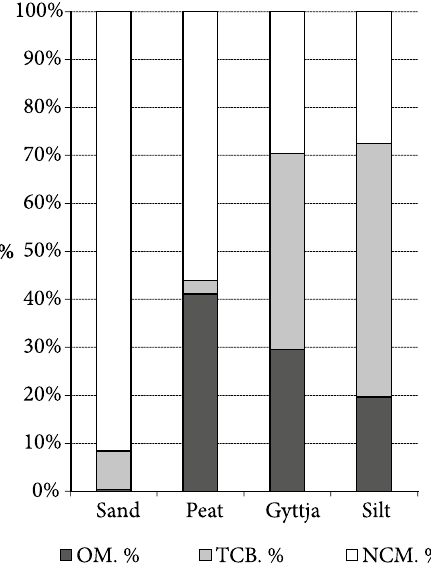
Fig. 5. Median percentage of main components in